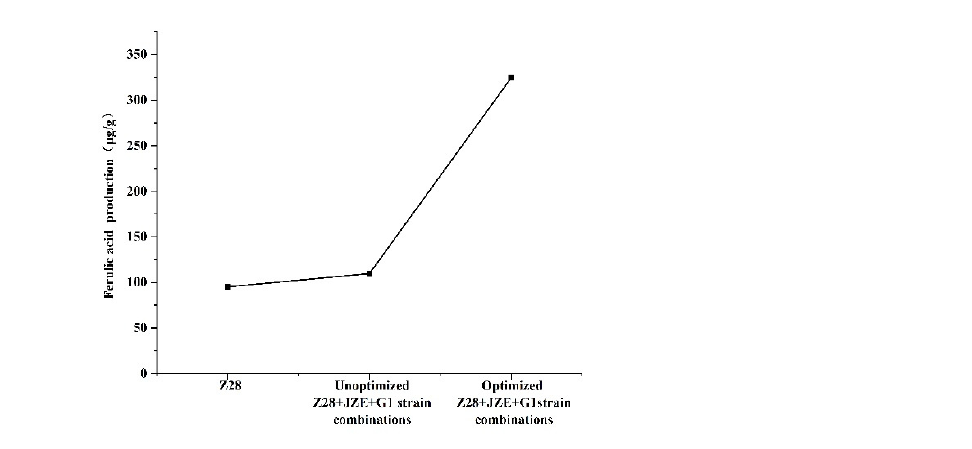
Figure 4. Comparative analysis of FA yield before and after optimization of optimal combination fermentation conditions.